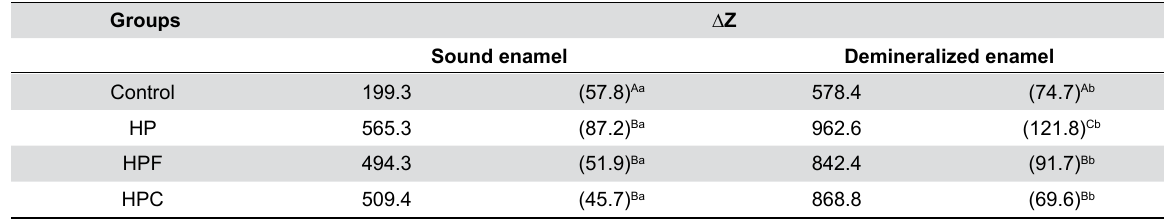
Table 5- Mean values and standard deviations of enamel mineral loss area (∆Z) of sound and demineralized enamel